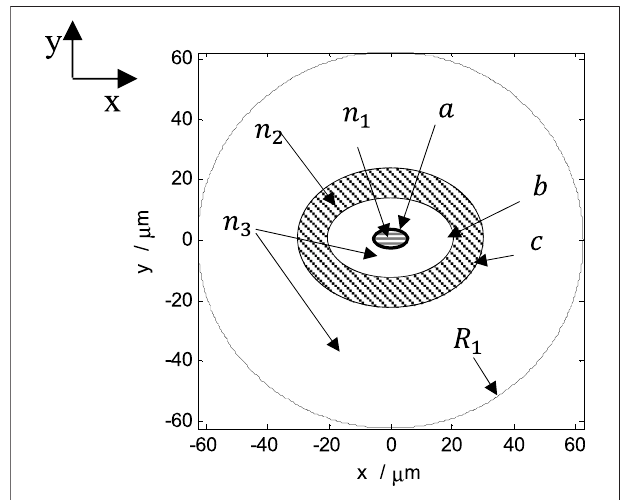
FIGURE 1 | Cross section of the